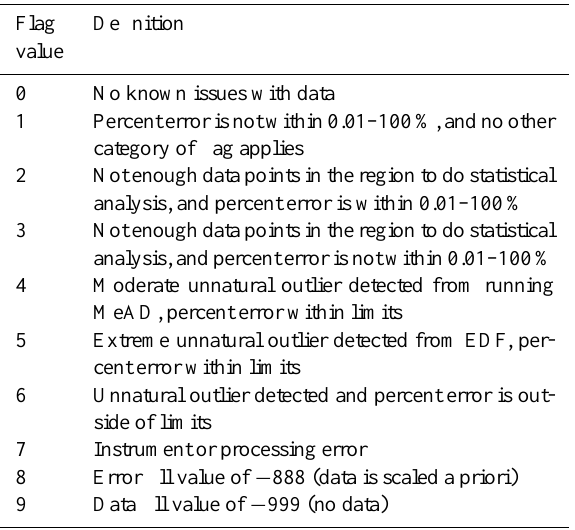
Table 2. Definition of flag values associated with ACE-FTS level 2